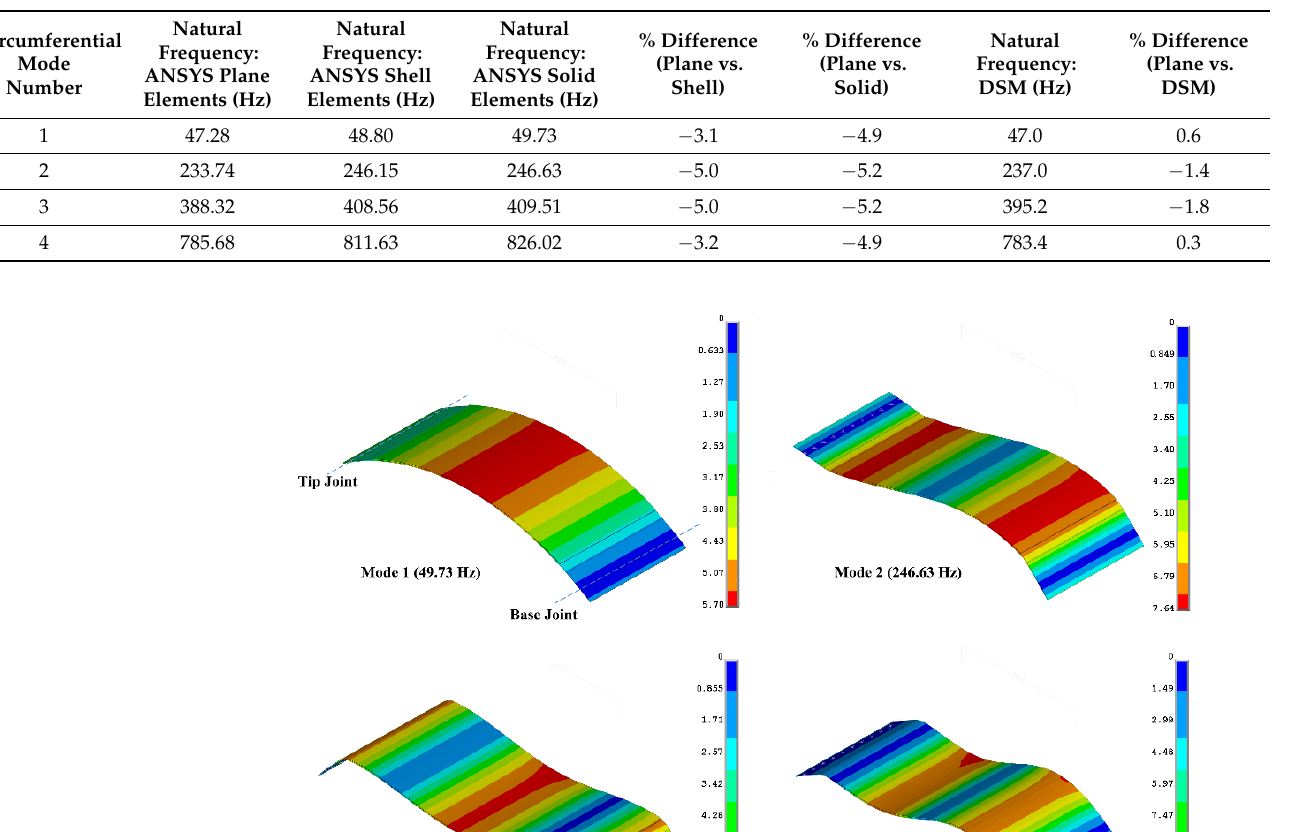
Table 3. Natural frequencies (Hz) of test rig obtained with ANSYS for pure short circuited load condition (no electrical effect), together with corresponding DSM results.